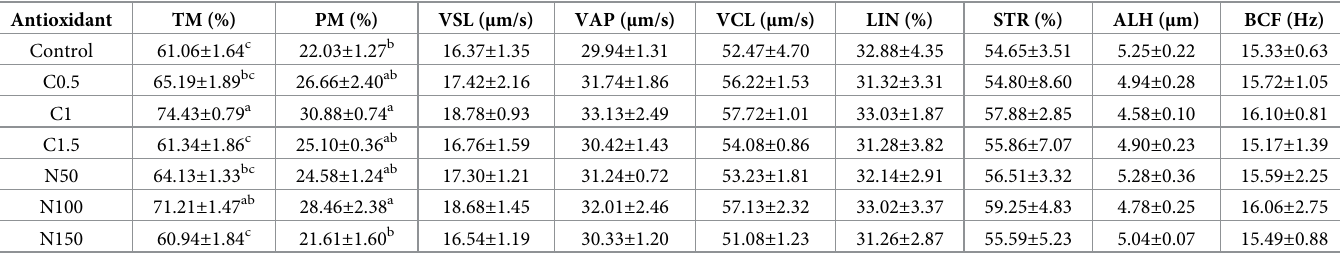
TM: Total motility (%); PM: Progressive motility (%); VSL: straight-line velocity ( μ m/s); VAP: Average path velocity ( μ m/s); VCL: curvilinear velocity ( μ m/s); LIN: Linearity (%); STR: Straightness (%); ALH: Mean amplitude of the lateral head displacement ( μ m); BCF: Mean of the beat cross frequency (Hz). Different superscripts within the same column indicate significant differences among groups (p < 0.05). Beltsville extender without antioxidant (control), C0.5 (Beltsville extender with 0.5 mM crocin), C1 (Beltsville extender with 1 mM crocin), C1.5 (Beltsville extender with 1.5 mM crocin), N50 (Beltsville extender with 50 μ M naringenin), N100 (Beltsville extender with 100 μ M naringenin), N150 (Beltsville extender with 150 μ M